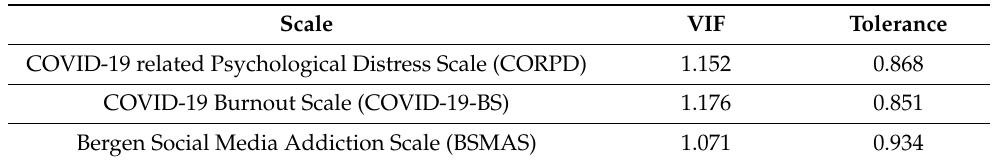
Table 2. VIF and Tolerance values of the arguments.